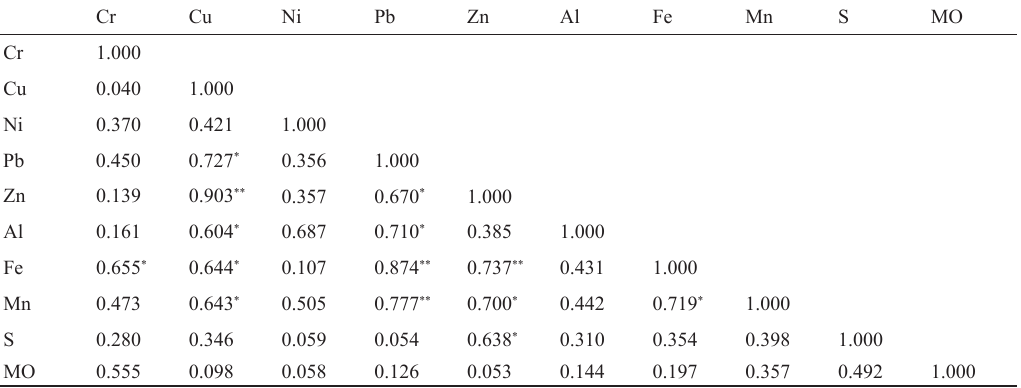
Pearson correlation coefficient for metals in the sediments along the Sinos River and tributaries.